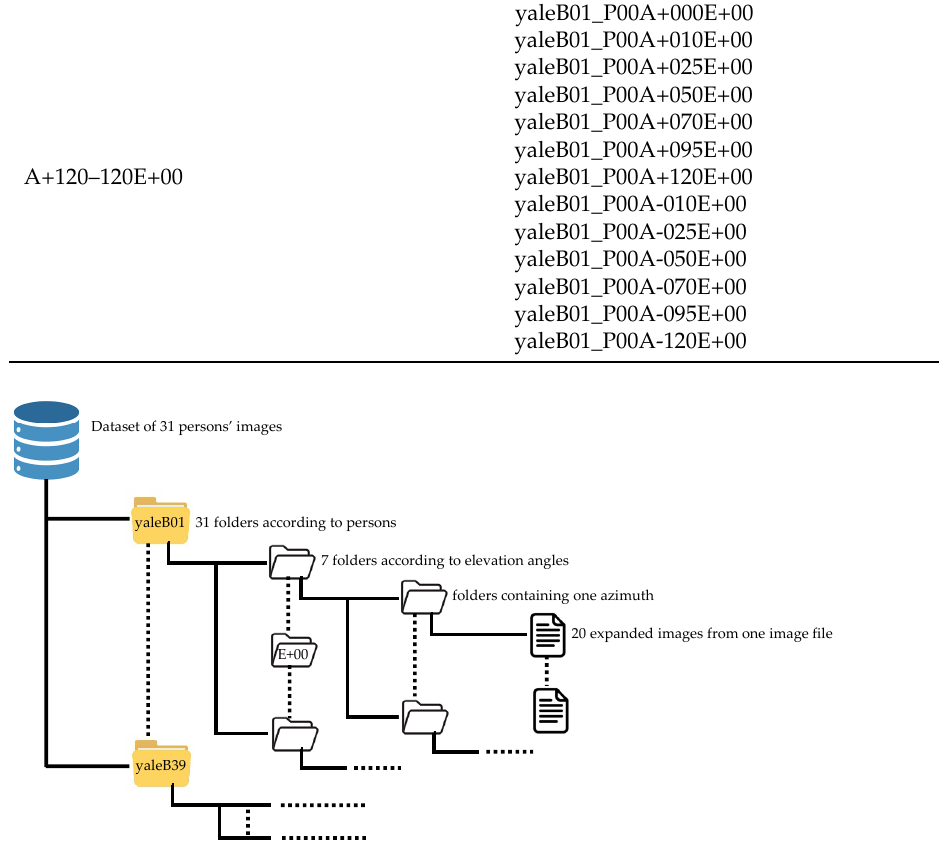
Figure 6. Group directory structure.